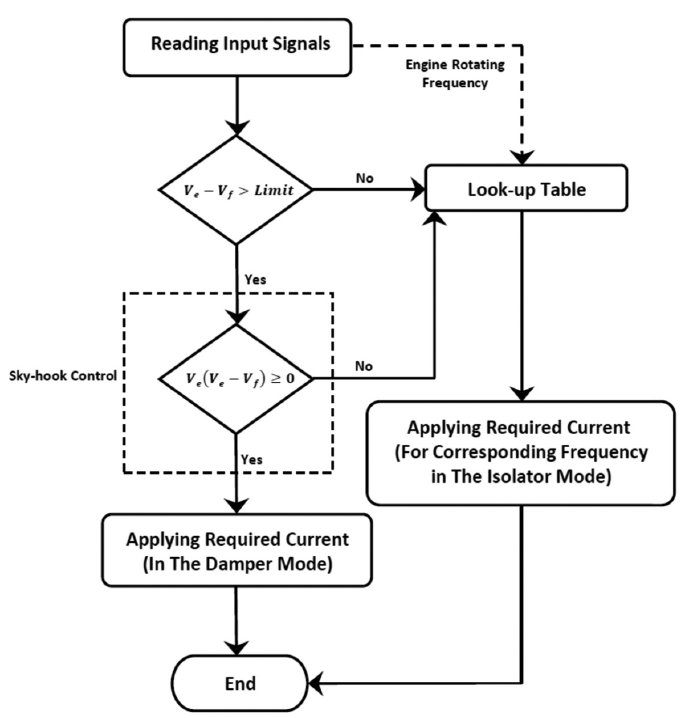
Fig. 14. Signal fl ows of the proposed